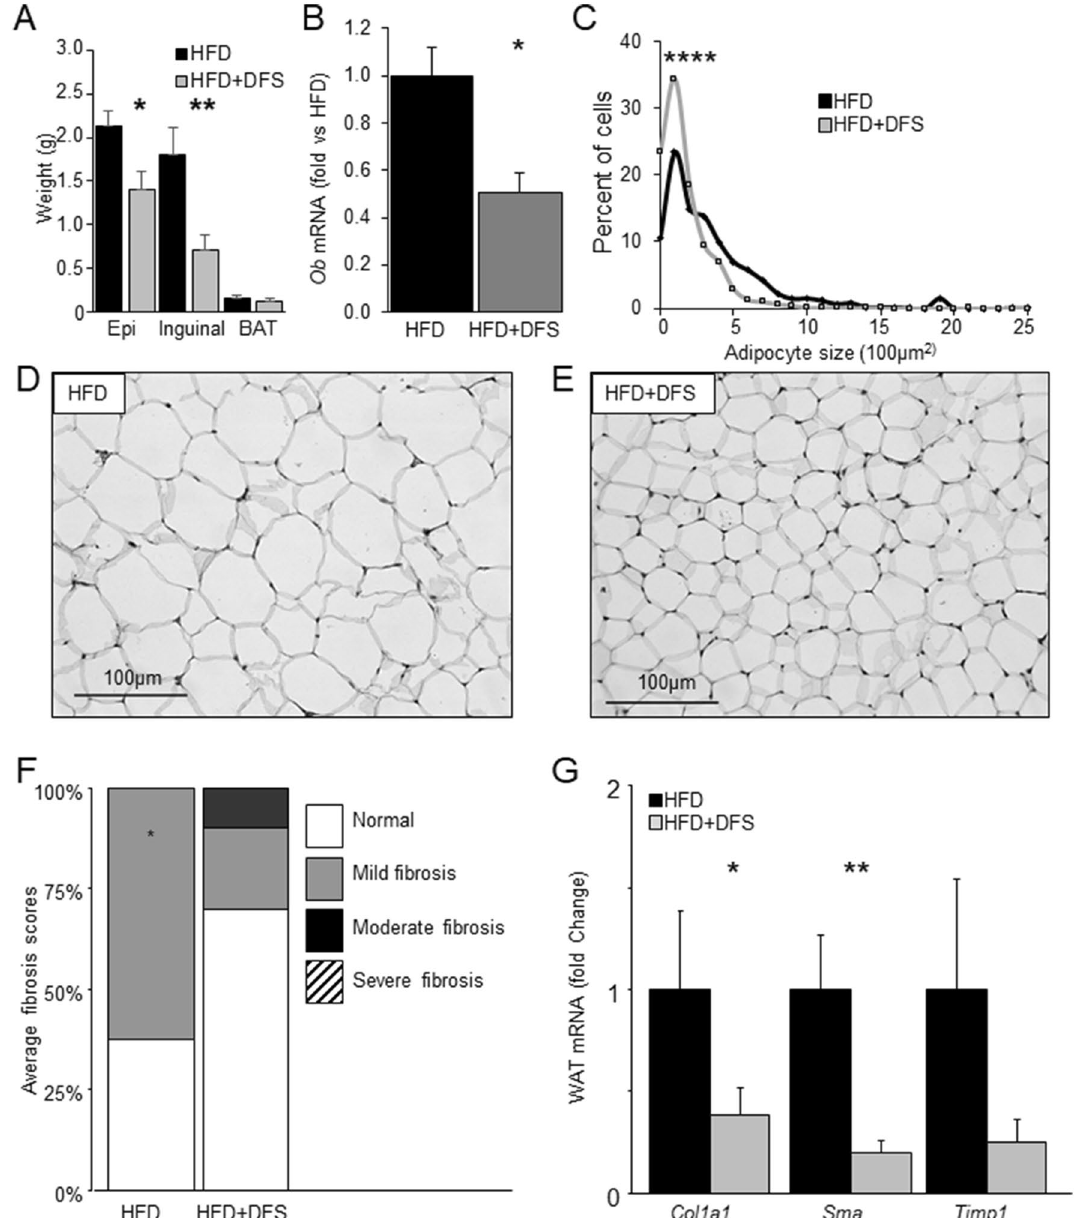
Figure 2. Deferasirox fed mice had lower fat weight and smaller adipocytes. ( A ) Fat pat weights of epigonadal (epi) and inguinal fat were lighter in HFD + DFS mice. Brown adipose tissue (BAT) weight was not significantly different. ( B ) Leptin mRNA ( Ob mRNA) was lower in fat from mice fed HFD + DFS. ( C ) Adipocytes were smaller mice receiving HFD + DFS. ( D , E ) representative histology pictures of fat from HFD and HFD + DFS mice. Scale bars are 100 µm. ( F ) Sirius red stained slides were scored for fibrosis, which was significantly lower in HFD + DFS mice. ( G ) Gene expression of genes associated with fibrosis was lower for Collagen 1a1 ( Col1 ), smooth muscle actin ( Sma ) and Timp1 (metalloproteinase inhibitor 1). *p < 0.05, **p < 0.01. Data is shown as mean ± SEM (standard error of the mean) unless otherwise